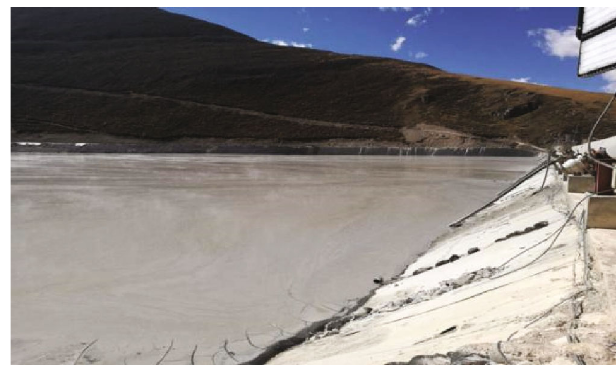
Figure 1: Tailing beach surface in the initial